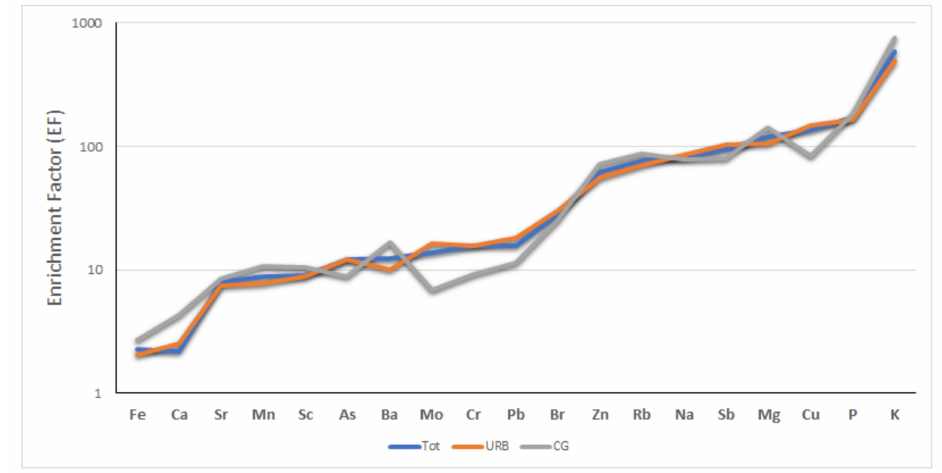
Figure 3. Average enrichment factors (EFs) for the analyzed elements in Ficus macrophylla